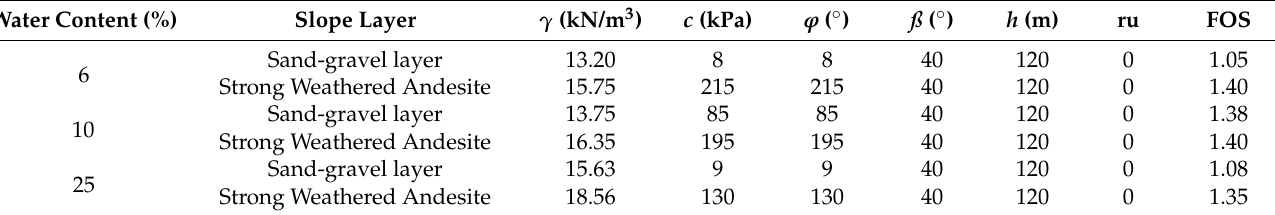
Table 8. Safety factor value based on ANN